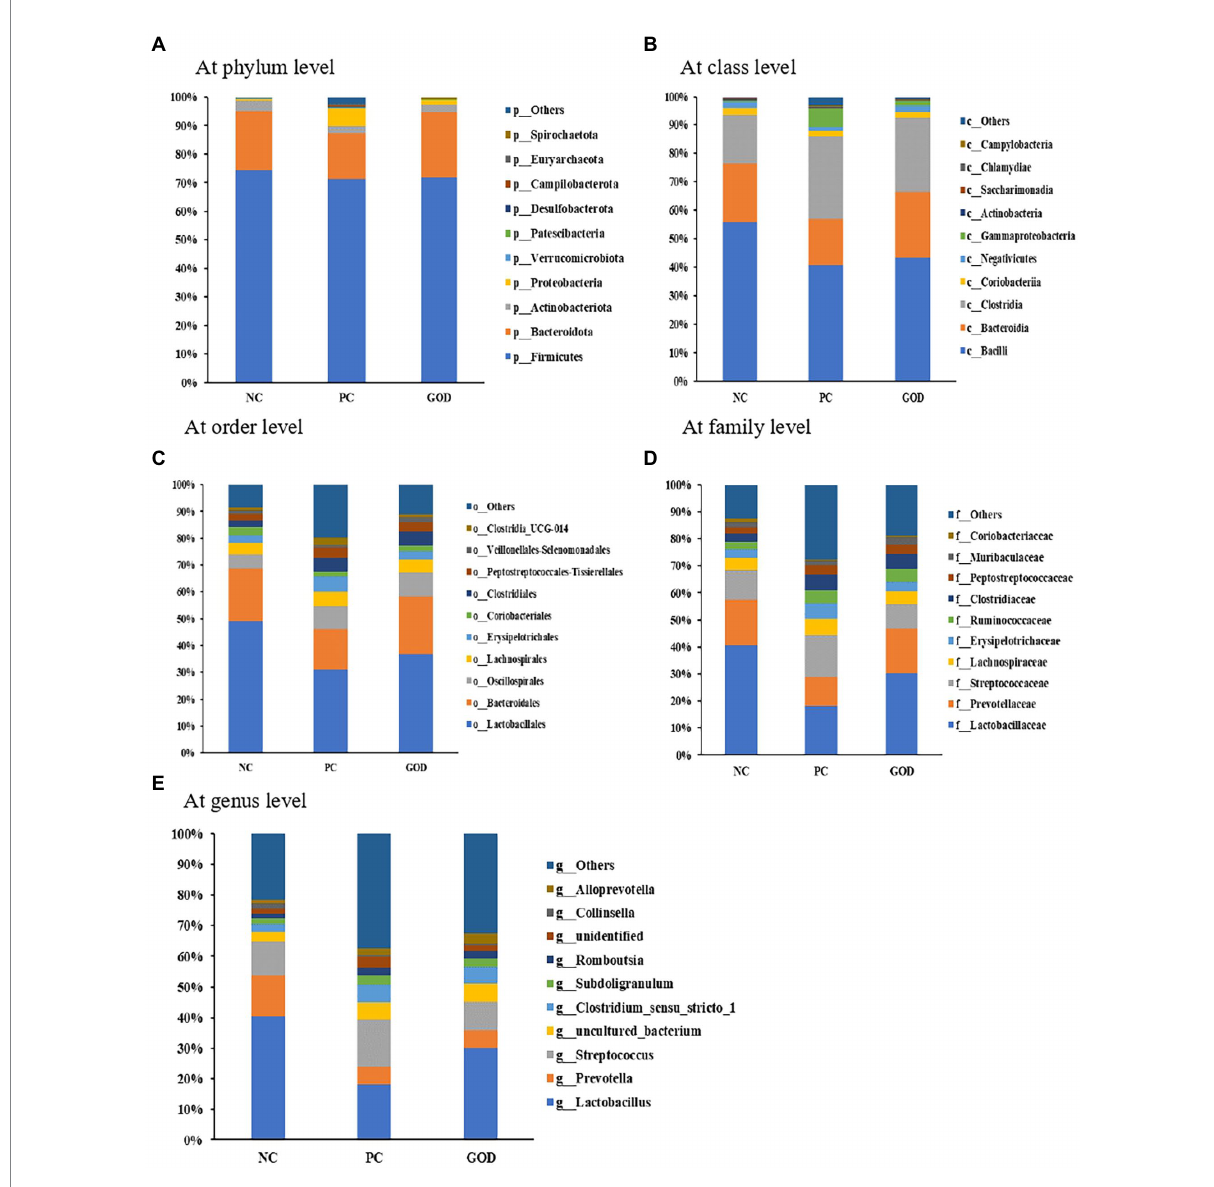
FIGURE 3 Gut microbial composition of piglets. (A) at phylum level; (B) at class level; (C) at order level; (D) at family level; (E) at genus level. NC, negative control (piglets were free of the challenge); PC, positive control (piglets were challenged with enterotoxigenic E. coli on the 11th day of the experiment); and GOD, PC piglets supplemented with 200 g/t glucose oxidase. Samples were analyzed on the 21st day of the